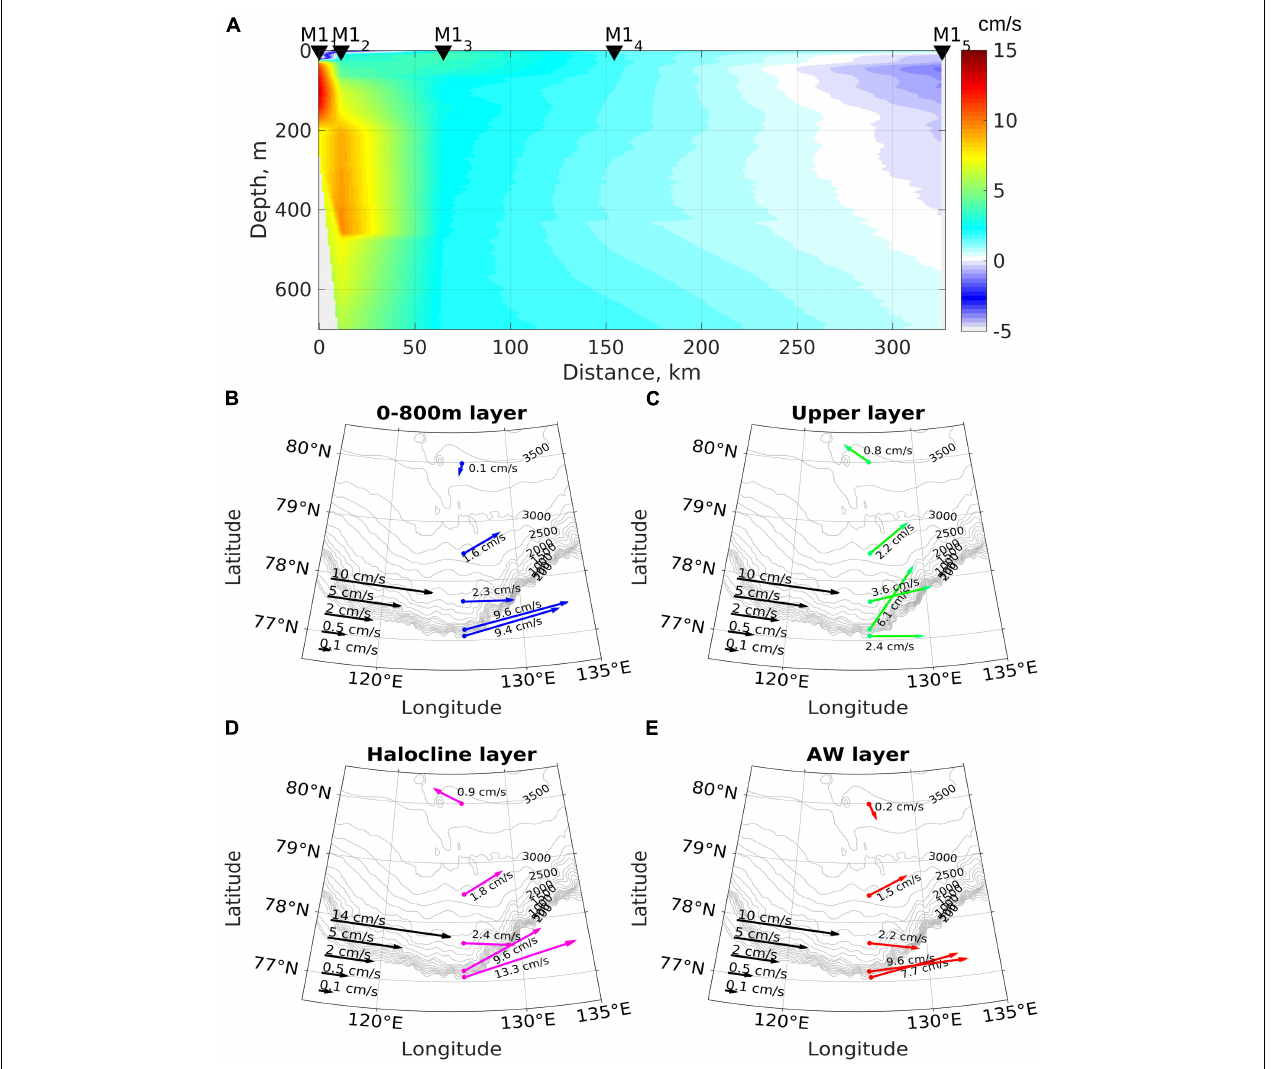
FIGURE 2 | Averaged over 2013–2018 eastward velocities (A) and current vectors (B–E) derived from mooring observations at the Laptev Sea slope in the upper 800-m layer (B) , in the upper 40-m layer (C) , in the halocline (70–140 m) layer (D) , and in the AW layer (E) . Note that a non-linear scale was used to plot